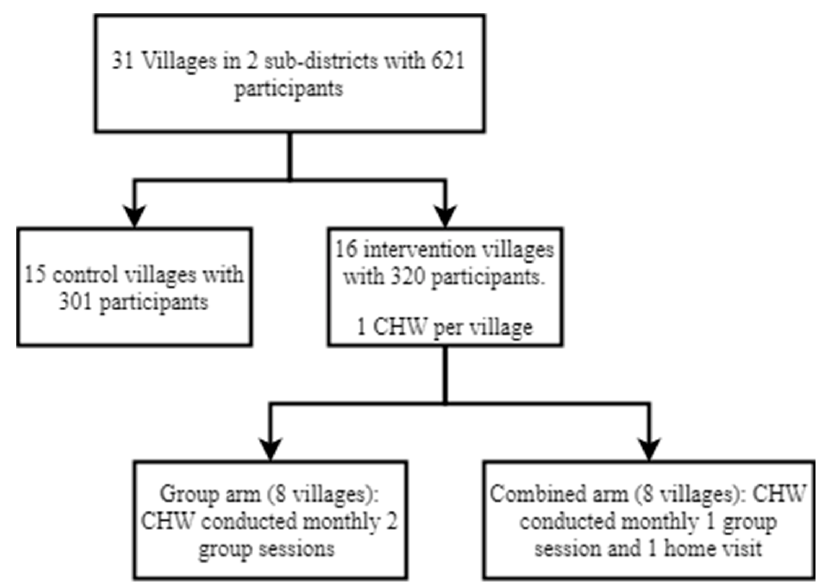
Figure 1. The RINEW study settings and participants.